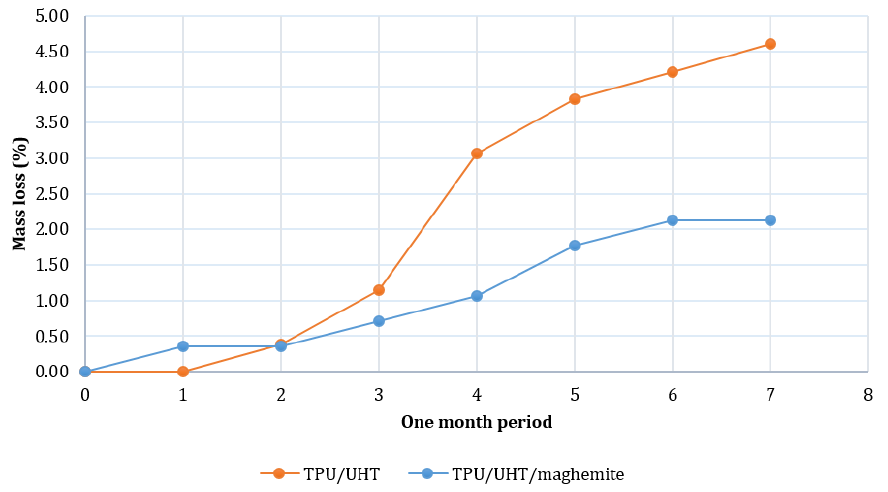
Figure 7. Plot of degradation rate over a period of one month.